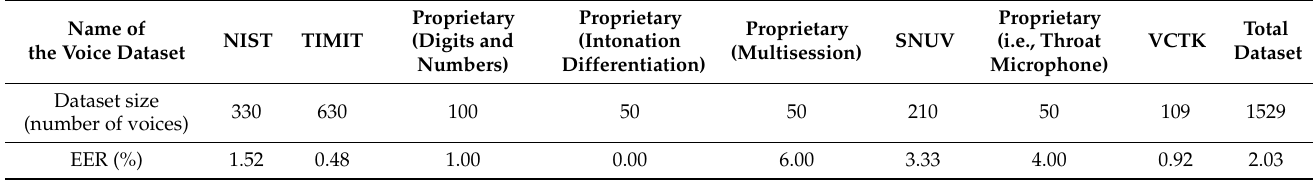
Table 1. Results of speaker equal error rate in particular voice datasets.